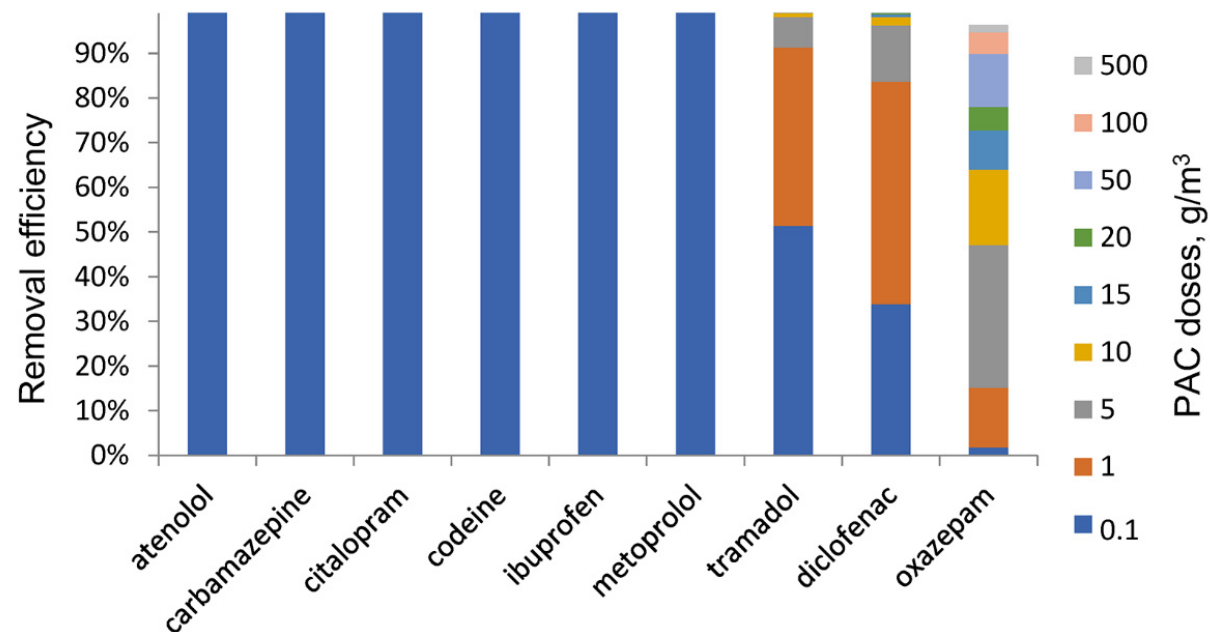
Figure 1. Amount of PAC needed in order to reach 99% reduction if the concentration of the pharmaceuticals was 1000 ng/L in the wastewater effluents. These pharmaceuticals were measured in the range of 100–1000 ng/L.